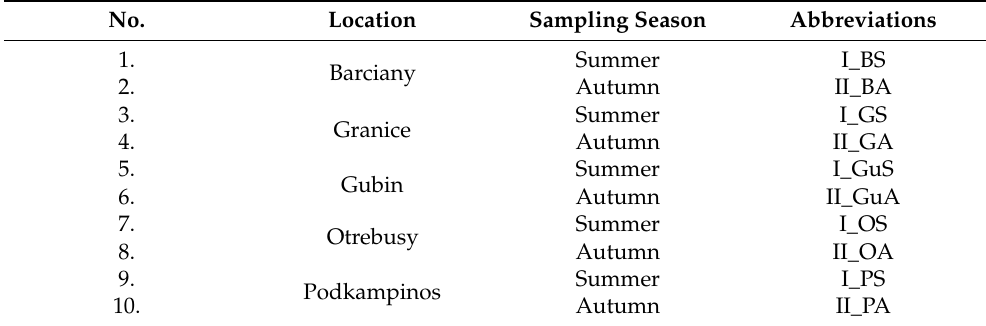
Table 2. Leaf samples